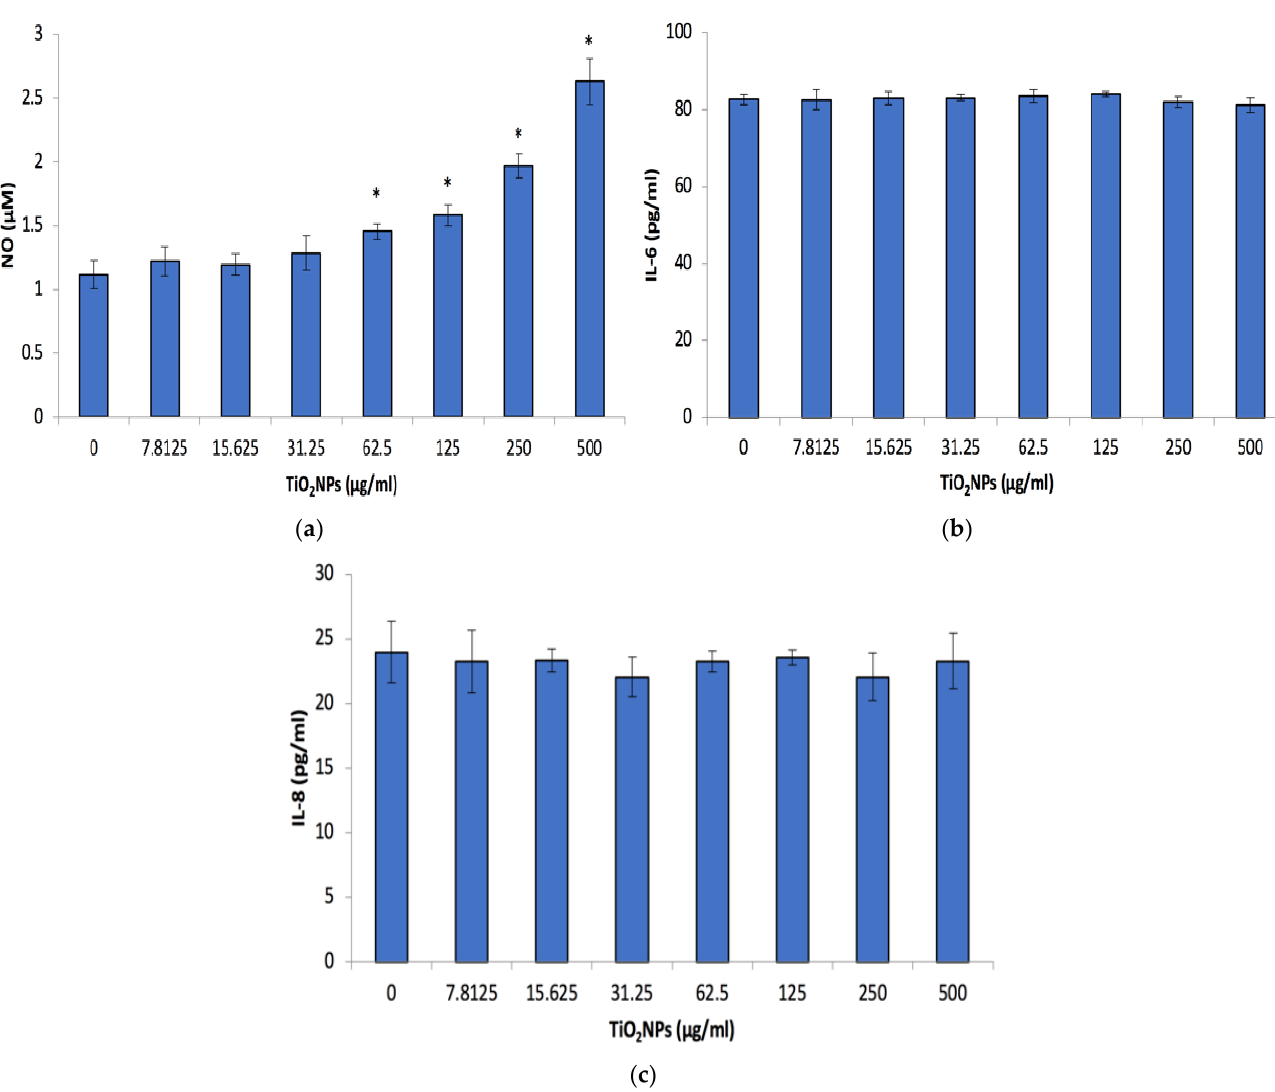
Figure 4. Caco-2 Nitric oxide (NO), Interleukin 6 (IL-6) and Interleukin 8 (IL-8) ( a – c ) respectively after 48 h exposure to a range of TiO 2 NP concentrations. Data represented as mean ± SD. Significance demarcated by *, indicating a significant difference of p < 0.001.